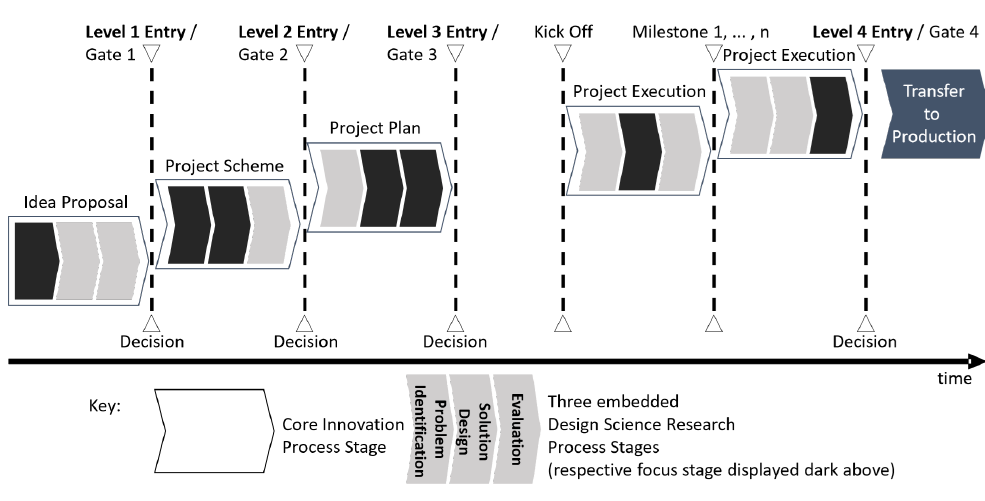
Figure 3. Combined Innovation and Research